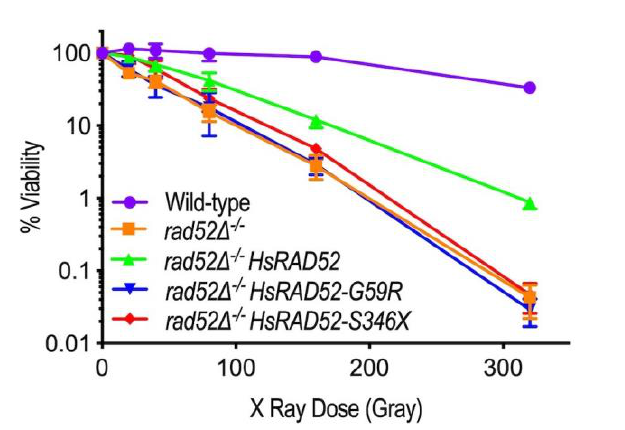
OPEN ACCESS | www.microbialcell.com 272 Microbial Cell | OCOTOBER 2020 | Vol. 7 No. 10